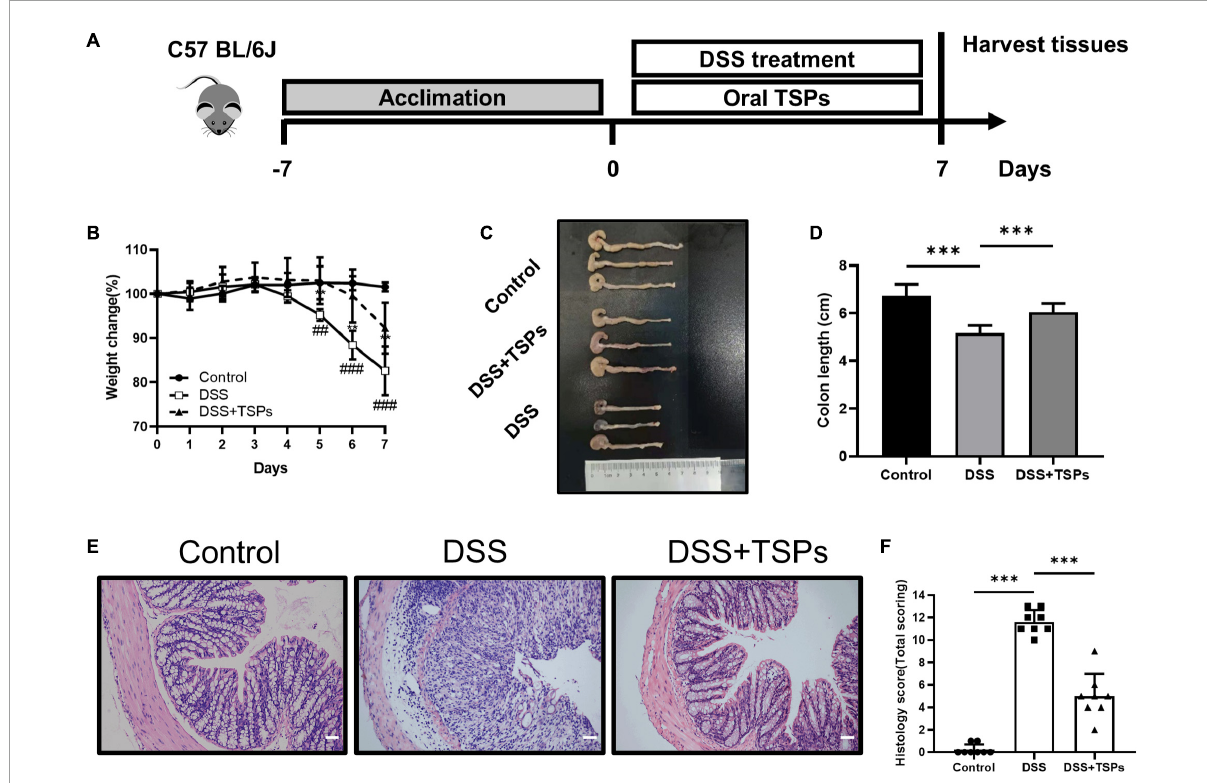
FIGURE5 Oral TSPs administration alleviated DSS-induced colitis. (A) Graphical description of experimental design of this study. (B) Daily body weight changes following DSS treatment ( n = 8). Statistical significance was determined using two-way ANOVA. ** P < 0.01 relative to DSS group; ## P < 0.01, ### P < 0.001 relative to Control group. (C) Macroscopic pictures of colons and (D) the statistical colon length from different groups ( n = 8). (E) H & E stained colon sections and (F) histological scores of colons ( n = 8). Data were presented as means ± SD. Statistical